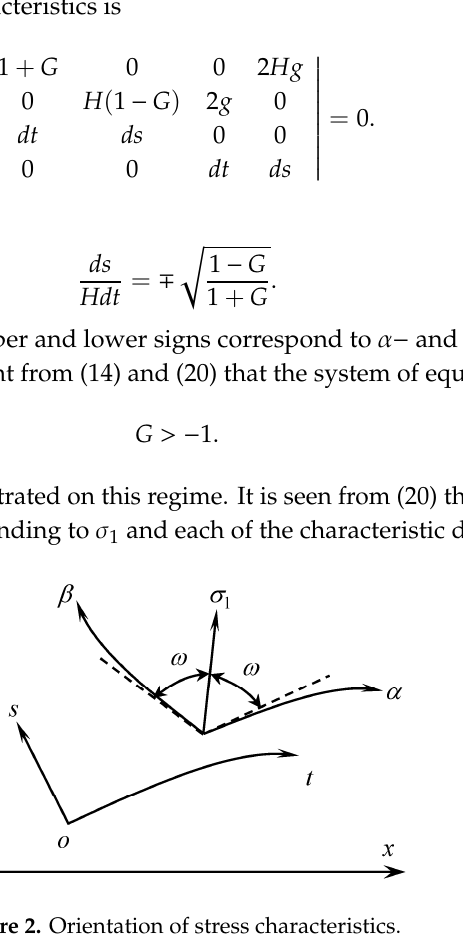
Figure 2. Orientation of stress characteristics.